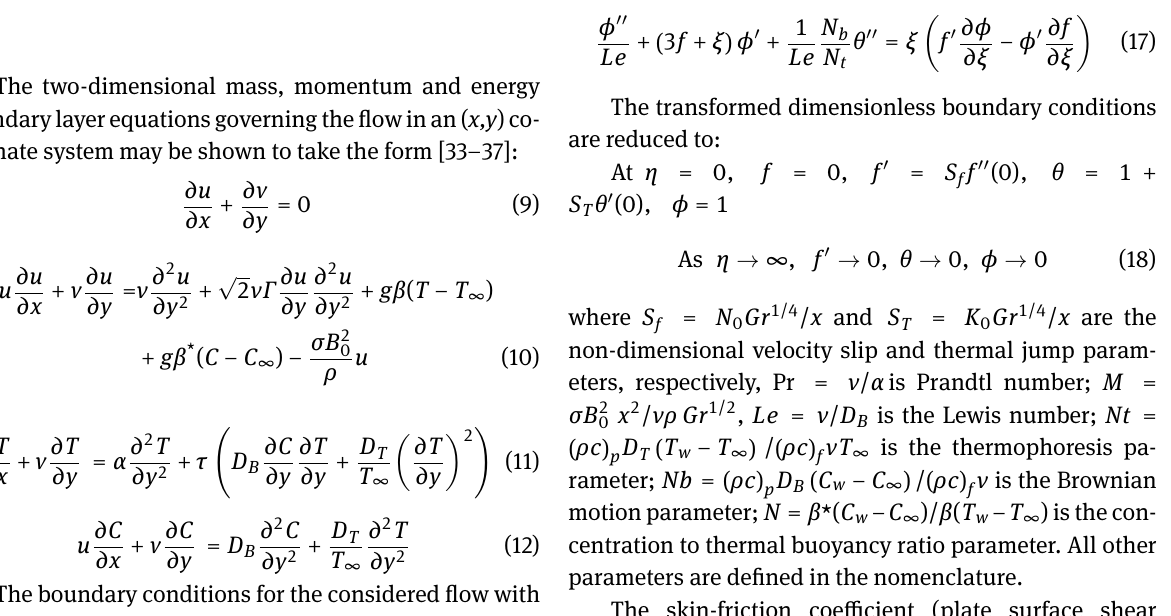
Fig. 1: Magnetohydrodynamic non-Newtonian heat transfer from a vertical